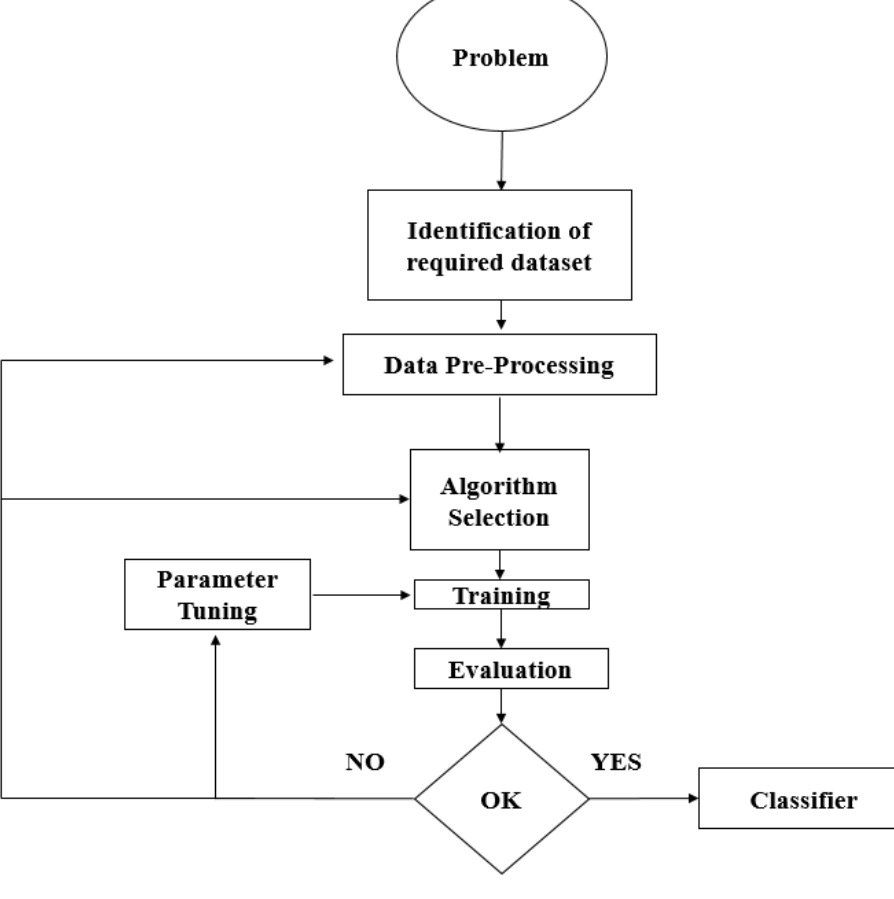
Figure 6. Training and optimization flowchart [7].